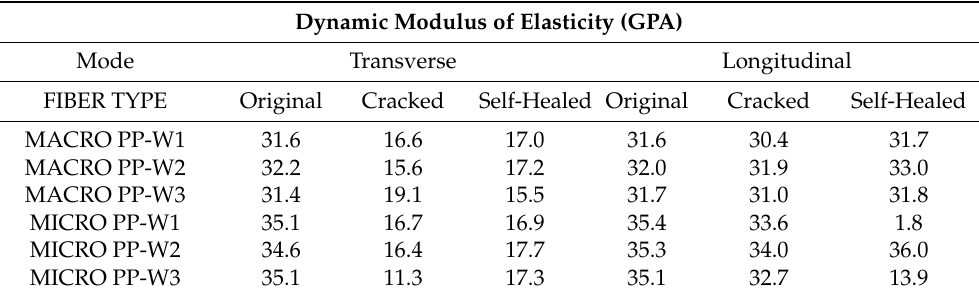
Figure 8. Transverse mode vibration and resonant frequency of self-healed micro PFRC cylinder. Table 8. Dynamic modulus of elasticity of water-cured PFRC